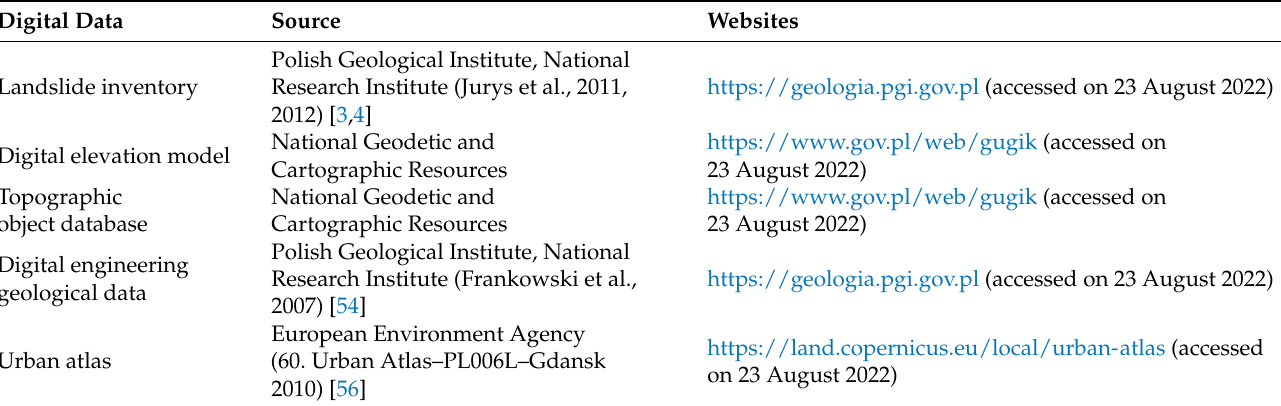
Table 1. Spatial digital data used in GIS analysis.